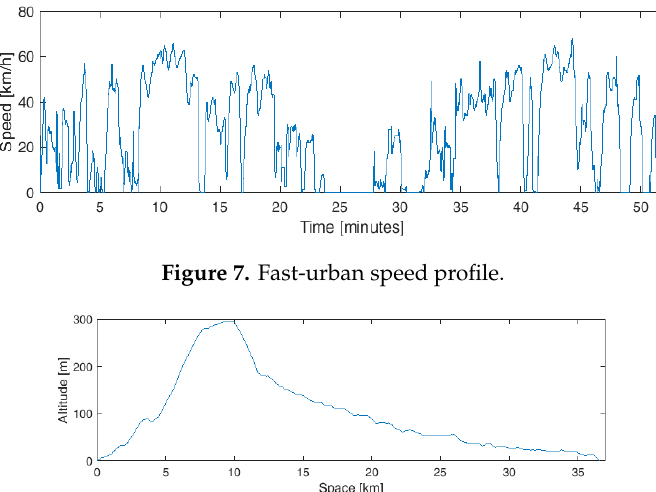
Energies 2019 , 12 , x FOR PEER REVIEW Figure 8. Extra-urban 1 altitude profile. Figure 8. Extra-urban 1 altitude profile. Figure 8. Extra-urban 1 altitude profile.